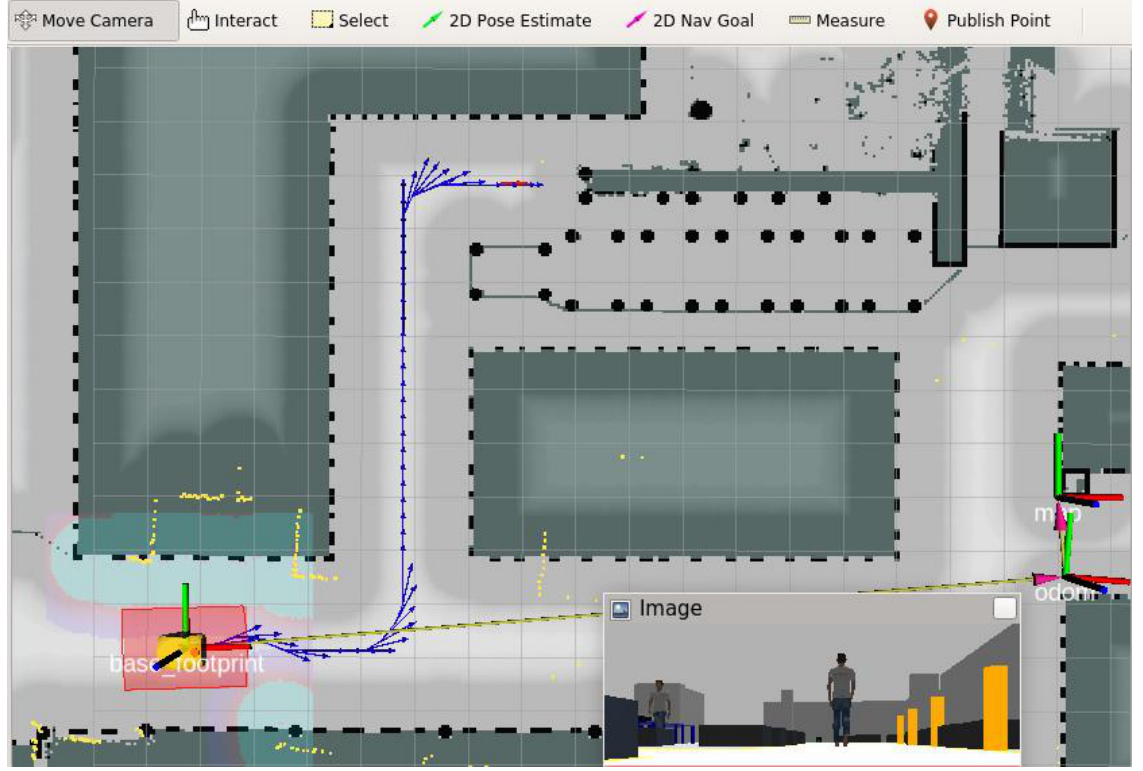
Figure 7. Visualization of calculated path for AMR to the dock position (at the top), blue arrows show subsequent desired poses of AMR.